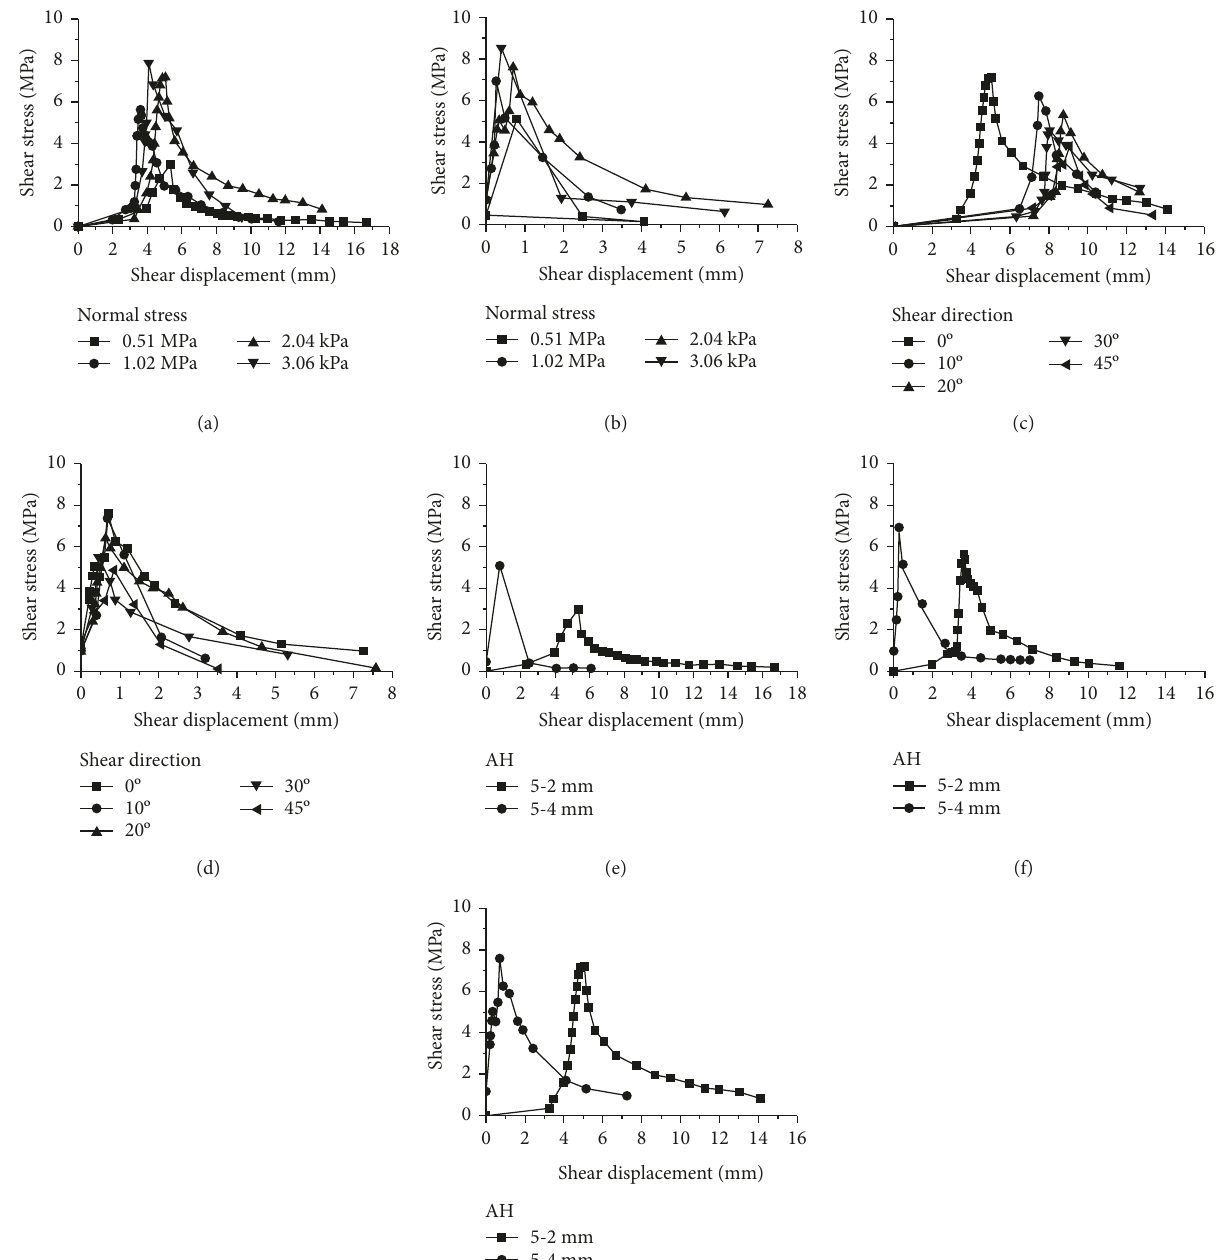
Figure 17: Shear strength and shear displacement of the quasi-3D discontinuity. (a) AH NS 2.04MPa; (c) AH (cid:31) SD 0 ° ; (g) NS (cid:31)